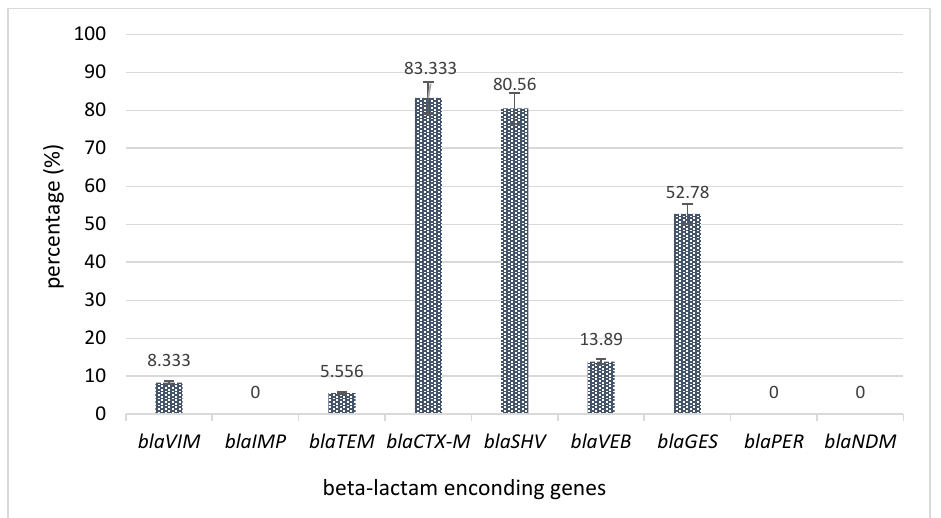
Figure 3. The carbapanamase- and ESBL-encoding genes (%) expressed by P. aeruginosa strains.